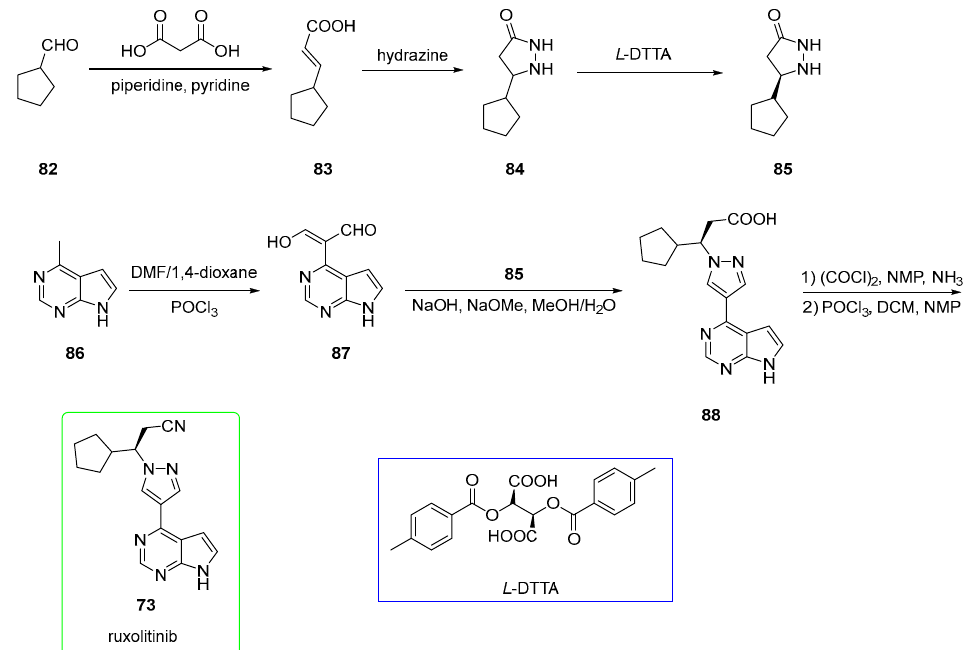
Scheme 15. Preparation of ruxolitinib ( 73 ) suitable for industrial production. Di- p -toluoyl- L -tartaric acid ( L -DTTA) is shown in the blue box